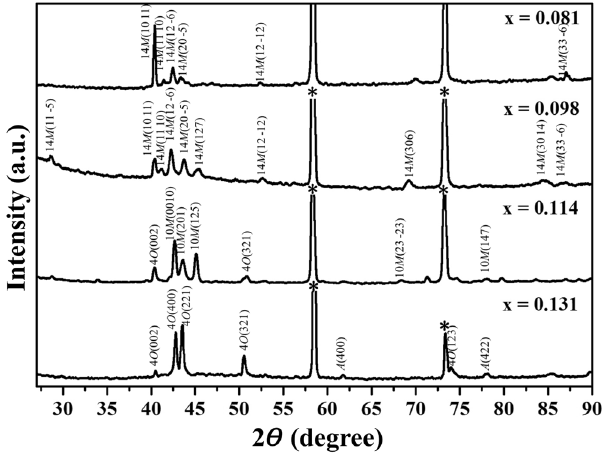
Figure 10. XRD patterns of the alloys (Ni 0.5 Mn 0.5 − x Sn x , 0.081 ≤ x ≤ 0.131) at room temperature (cubic W substrate reflections were marked with